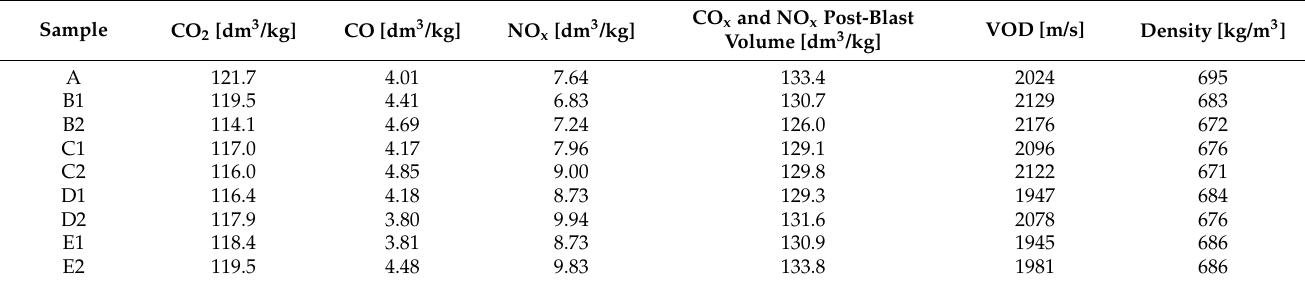
Table 2. Post-blast fumes, the velocity of detonation (VOD), and density of non-ideal ANFO with the addition of zeolite